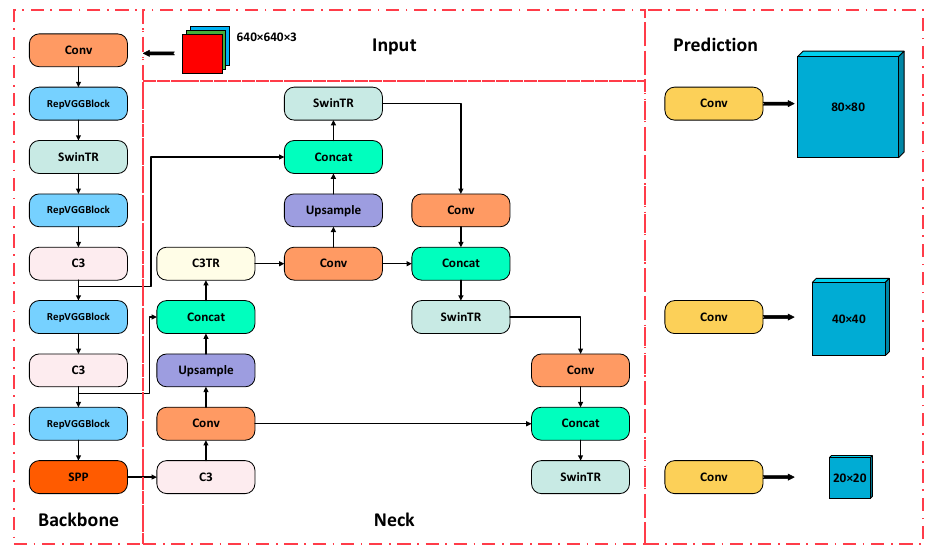
Figure 8. Improved YOLOv5s network structure.